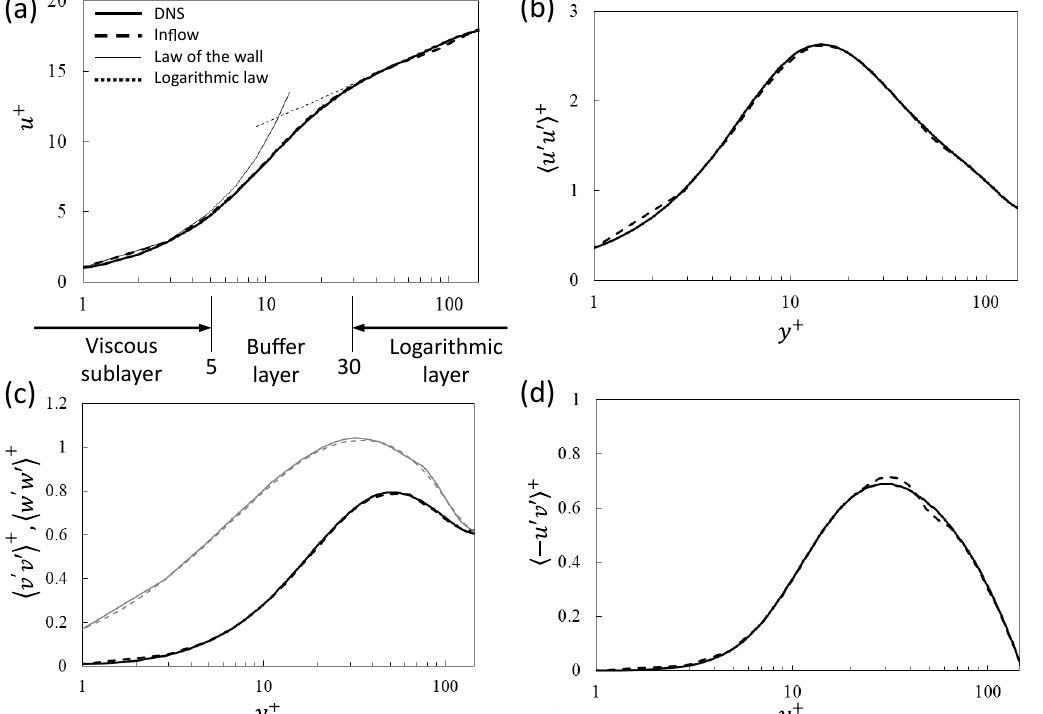
Figure 3. Statistical profiles from DNS and the synthetic inflow generator. ( a ) mean velocity profiles ( b ) streamwise stress profiles ( c ) vertical and transverse stress profiles ( d ) Reynolds stress